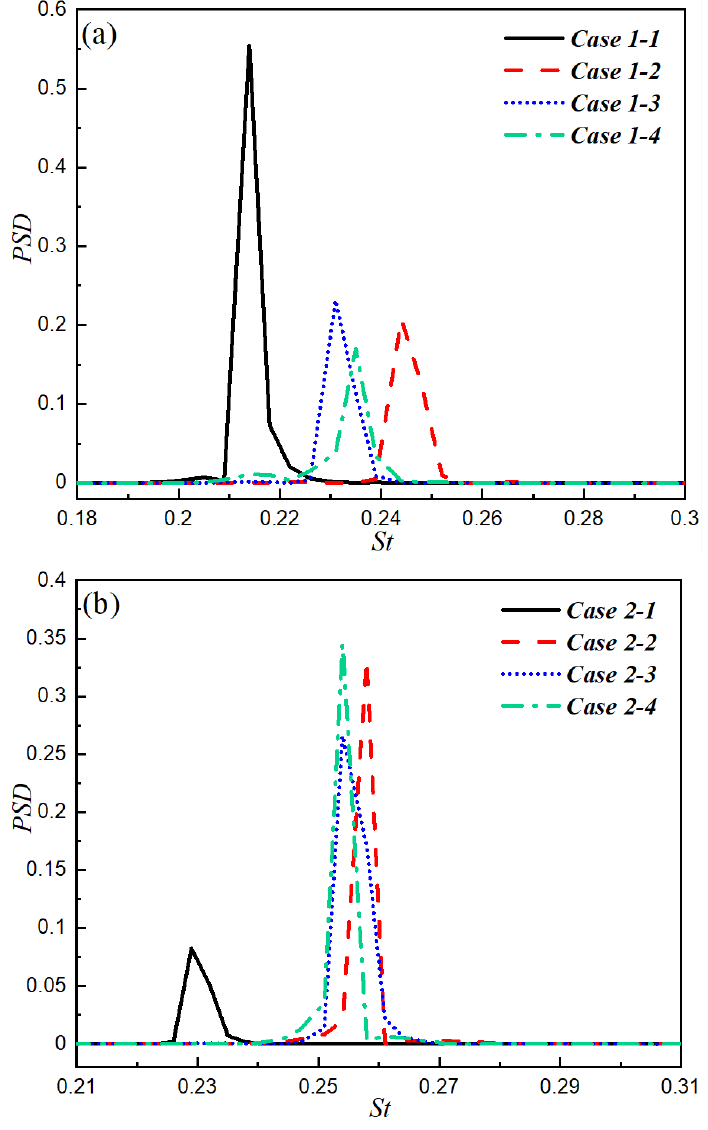
Figure 6. Power Spectral Density of lift coefficient of the cylinders with different dimple numbers: ( a ) Re = 1 × 10 5 ; ( b ) Re = 2 × 10 5